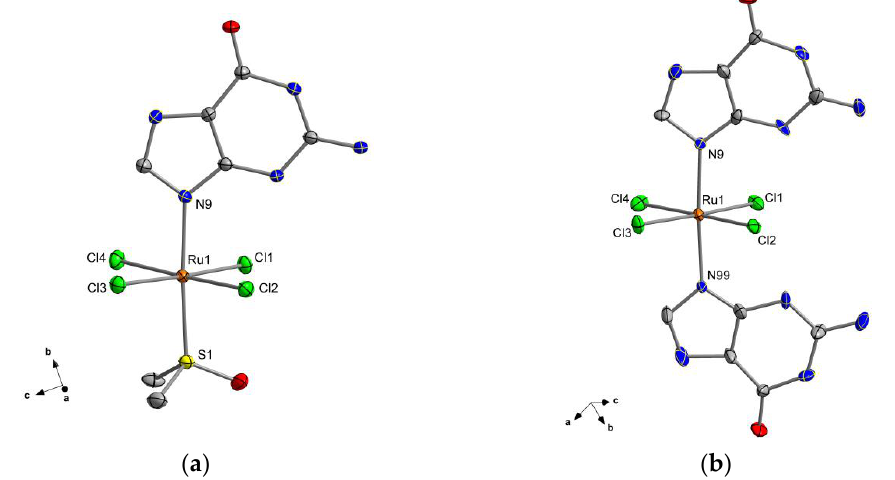
Figure 1. View of the [RuCl 4 (Hgua)(dmso)] and [RuCl 4 (Hgua)(gua)] complexes showing the atom numbering of the Ru(III) metal ions together with those of their chromophores in 1 ( a ) and 2 ( b ). Water molecules and H atoms have been omitted for clarity. Thermal ellipsoids are shown at the 50% of probability.